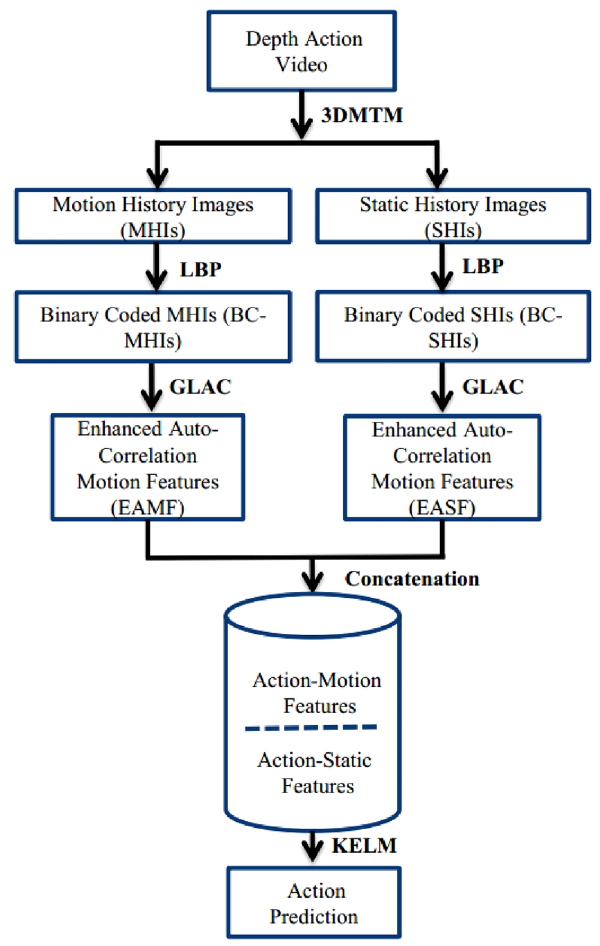
Fig. 1 Workflow illustration of our